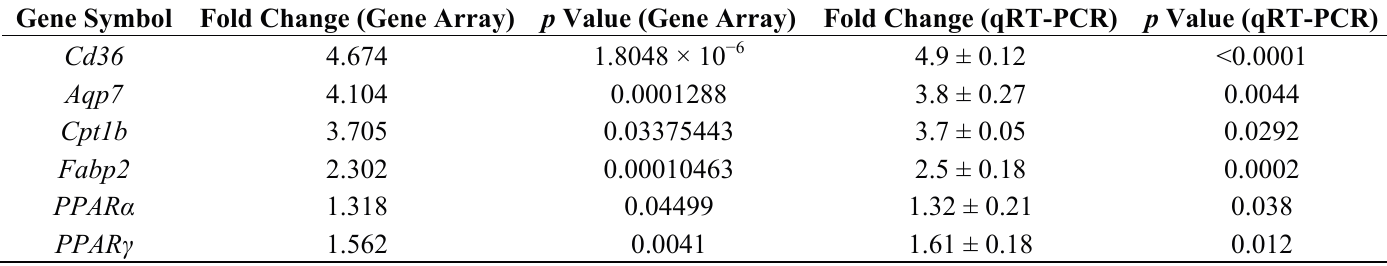
Table 4. Fold change of gene expression measured by gene array and qRT-PCR. Aqp7, aquaporin 7; Cpt1b, carnitine palmitoyltransferase 1b; Fabp2, fatty acid binding protein